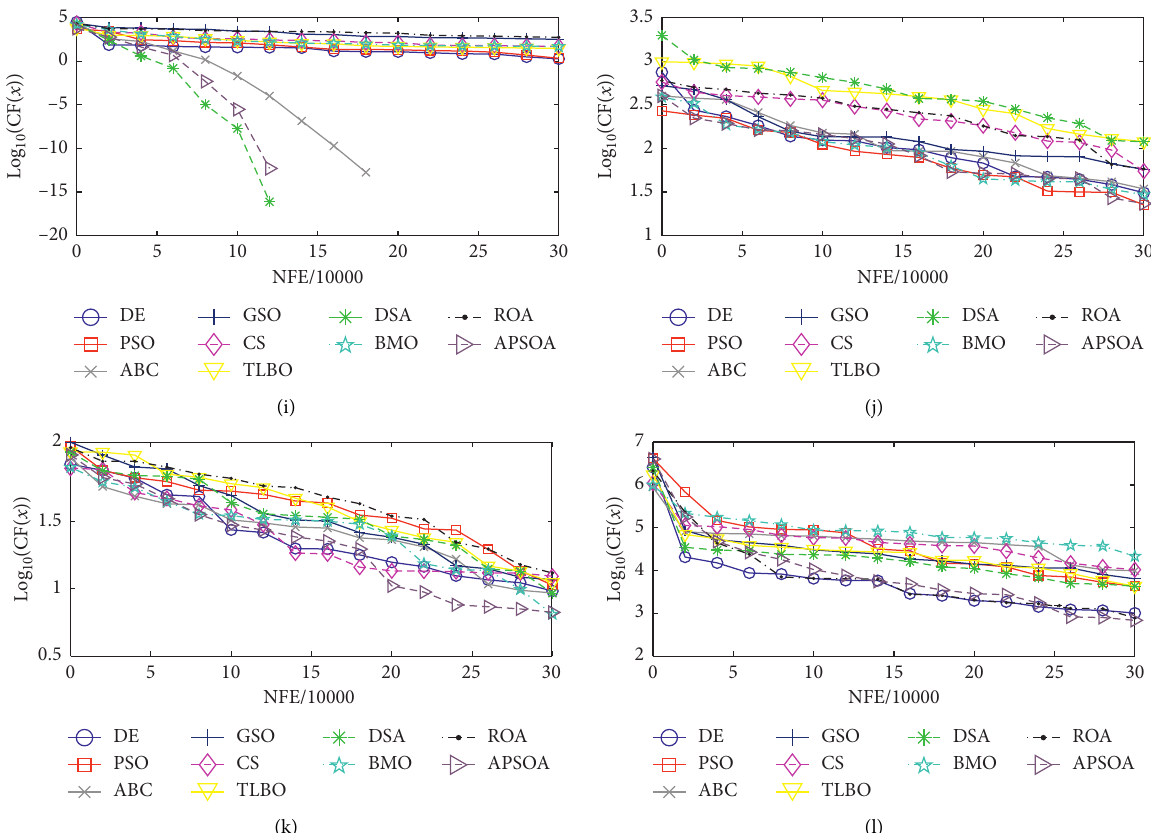
Figure 1: Convergence of different optimization algorithms in terms of the number of fitness evaluations on (a) F 1, (b) F 2, (c) F 3, (d) F 4, (e) F 5, (f) F 6, (g) F 7, (h) F 8, (i) F 9, (j) F 10, (k) F 11, and (l) F 12 benchmark functions in the CEC 2005